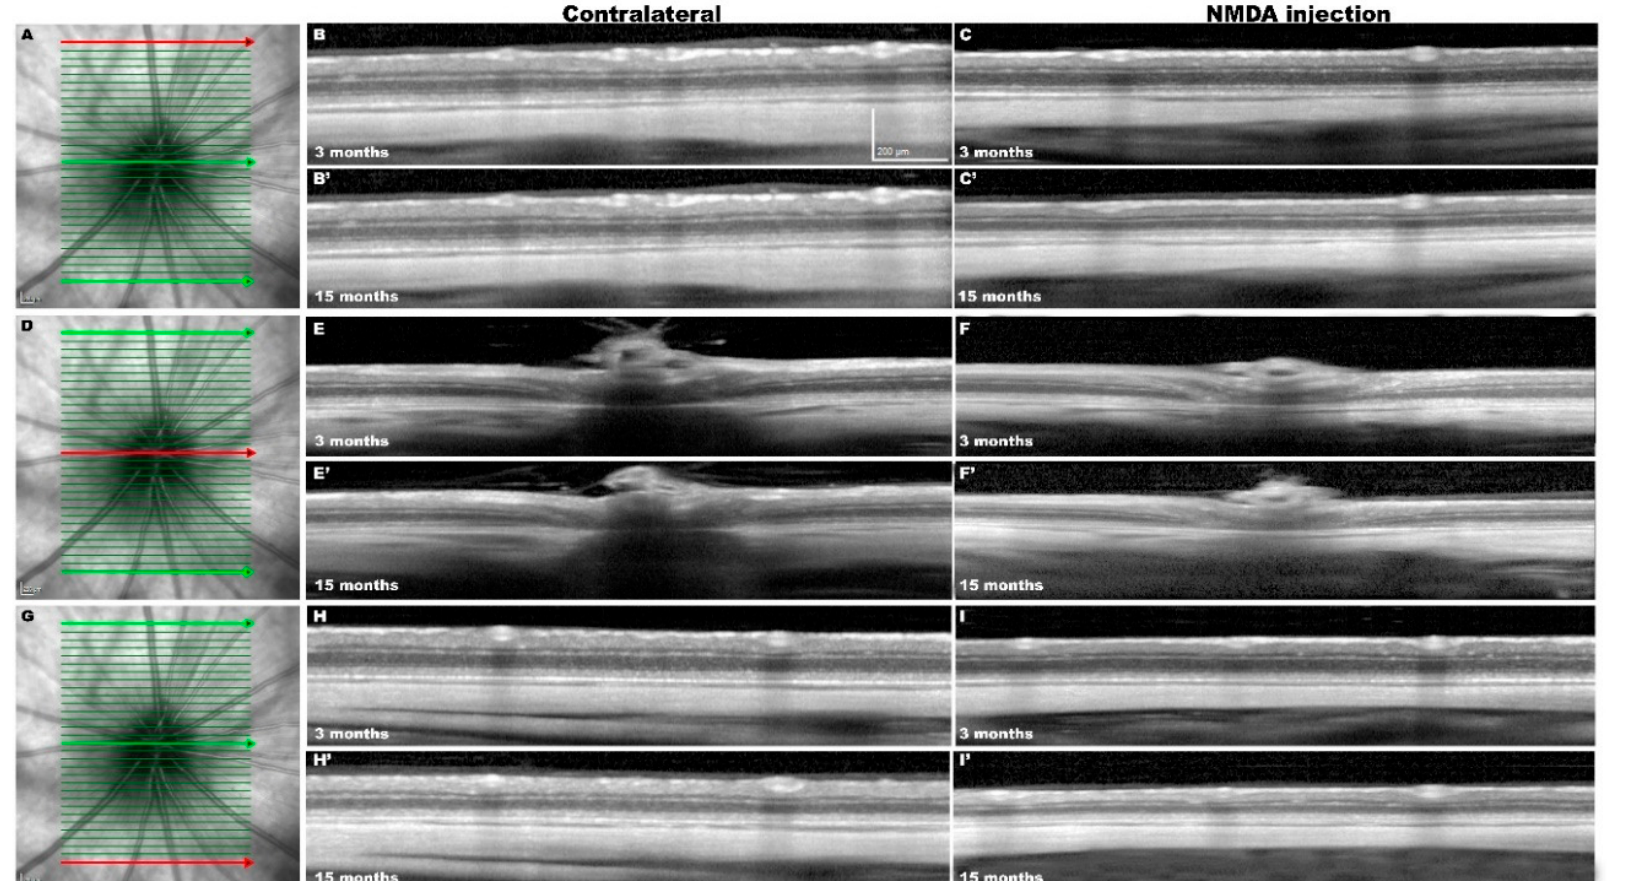
Figure 5. In vivo Spectral Domain-Optical Coherence Tomography (SD-OCT) images from the same contralateral and experimental retinas analyzed 3 and 15 months after NMDA injection. ( A , D , G ) Representative images of the ocular fundus of the contralateral retina and position of the 31 sections acquired. The superior ( A ), central ( D ), or inferior ( G ) retinal sections are marked in red. ( B , C , E , F , H , I ) Representative sections acquired (in red) from SD-OCT volume raster scan in contralateral ( B , E , H ) and NMDA-injected ( C , F , I ) retinas examined longitudinally at 3-months ( B – I ) and at 15-months ( B’ – I’ ) after NMDA injection.